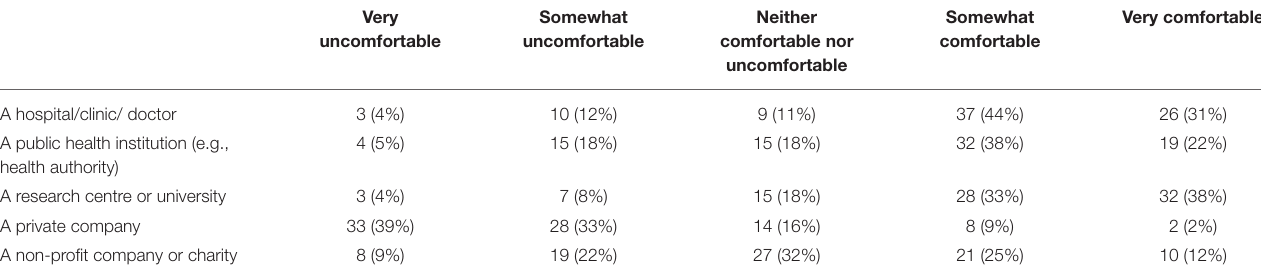
TABLE 7 | Answers to the question “How comfortable would you feel to share any of your mobile health data with the following?” ( n = 85). Very uncomfortable